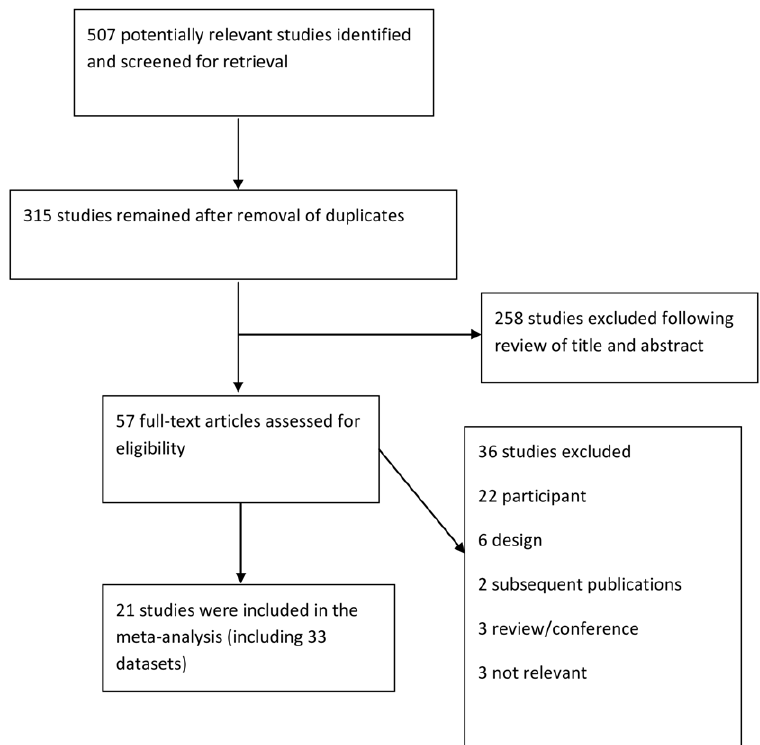
Figure 1. Flow diagram for identification of published studies for inclusion in review.